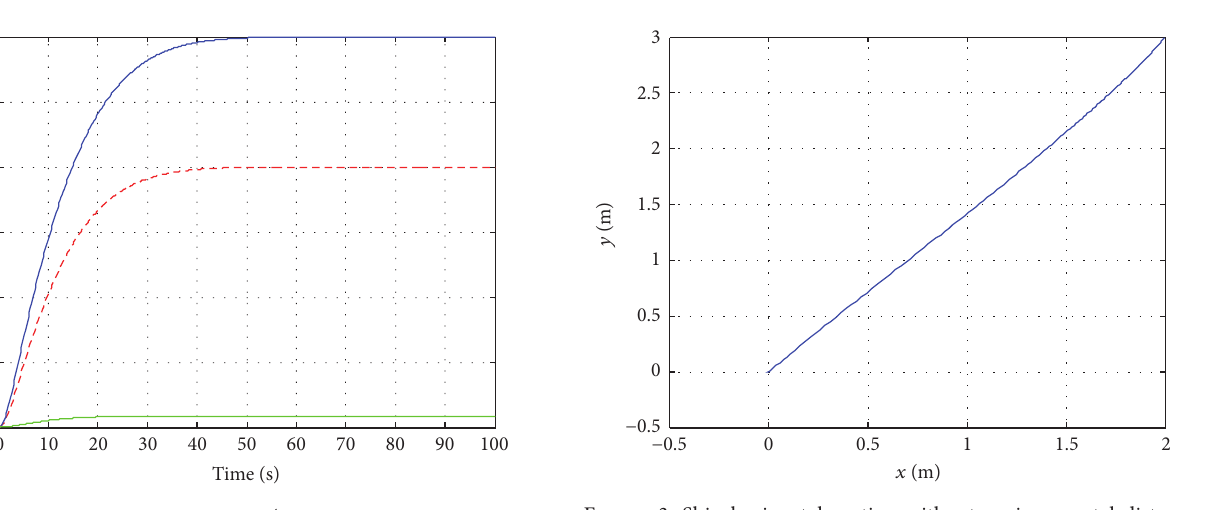
Figure 3: Ship horizontal motion without environmental distur- bances.